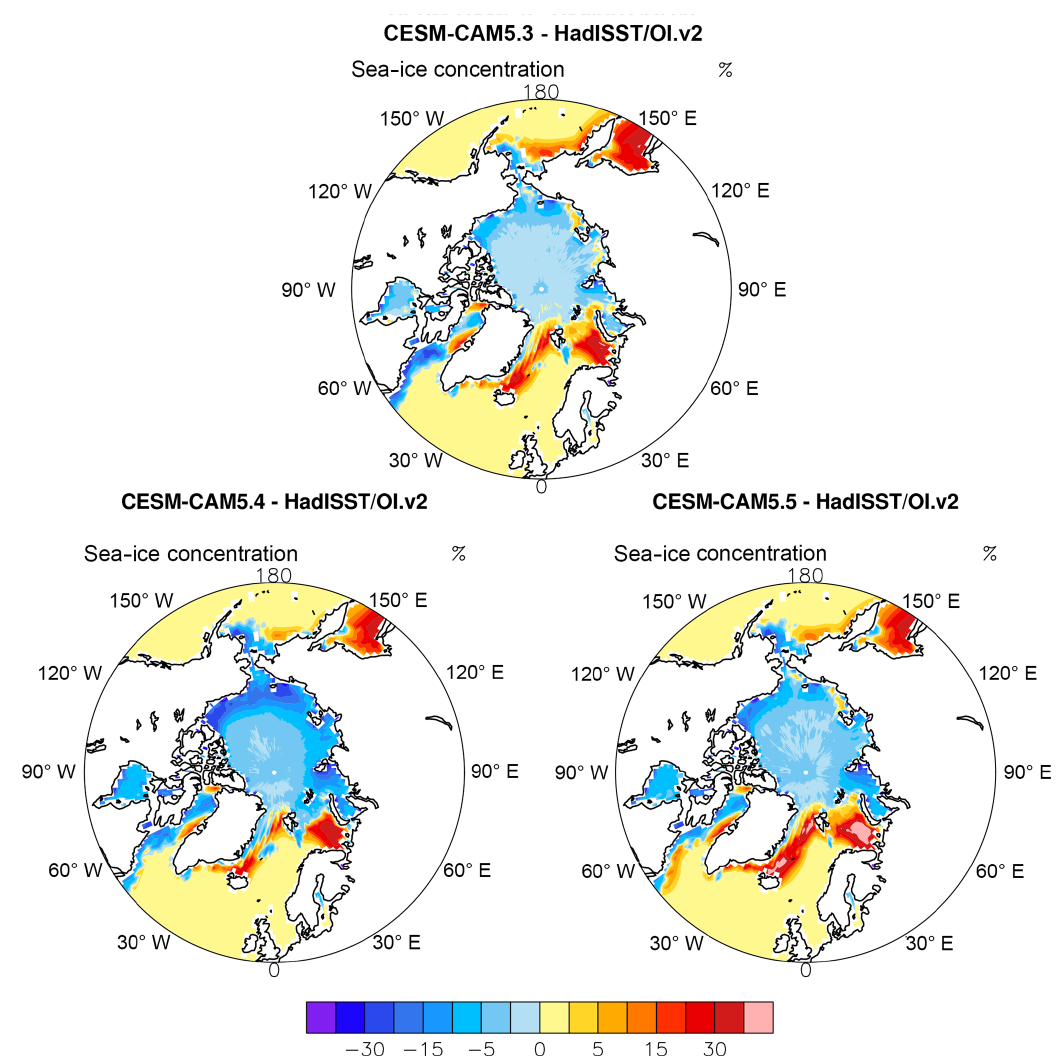
Figure 10. Same as Fig. 2 but for sea-ice concentration over the North Pole computed relative to pre-industrial HadISST